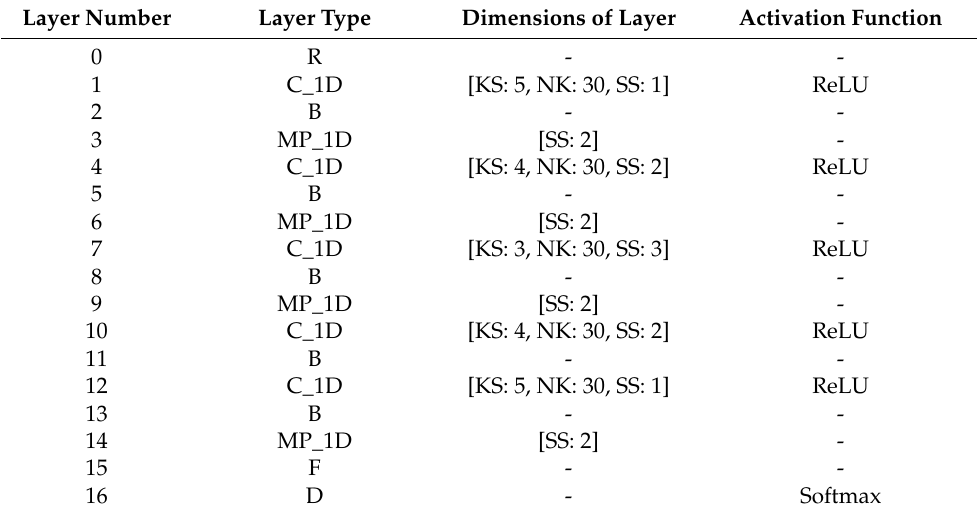
Table 6 presents the memory requirement parameters and performance while process- ing of single input vector data for the described above CNN Table 6 . The designed network parameters.